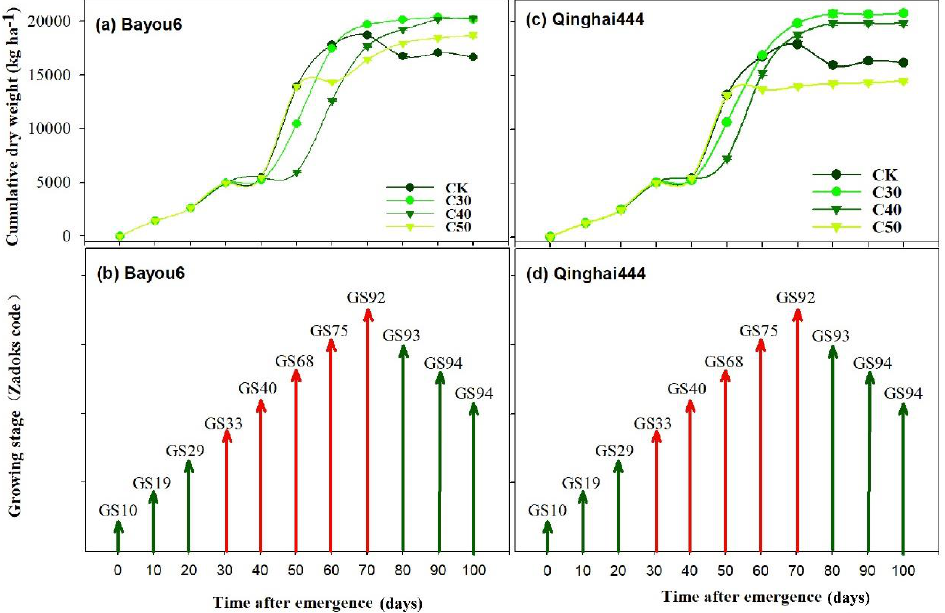
Table 4. Effects of cutting stage on growth days for oat species of Bayou6 and Qinghai444.